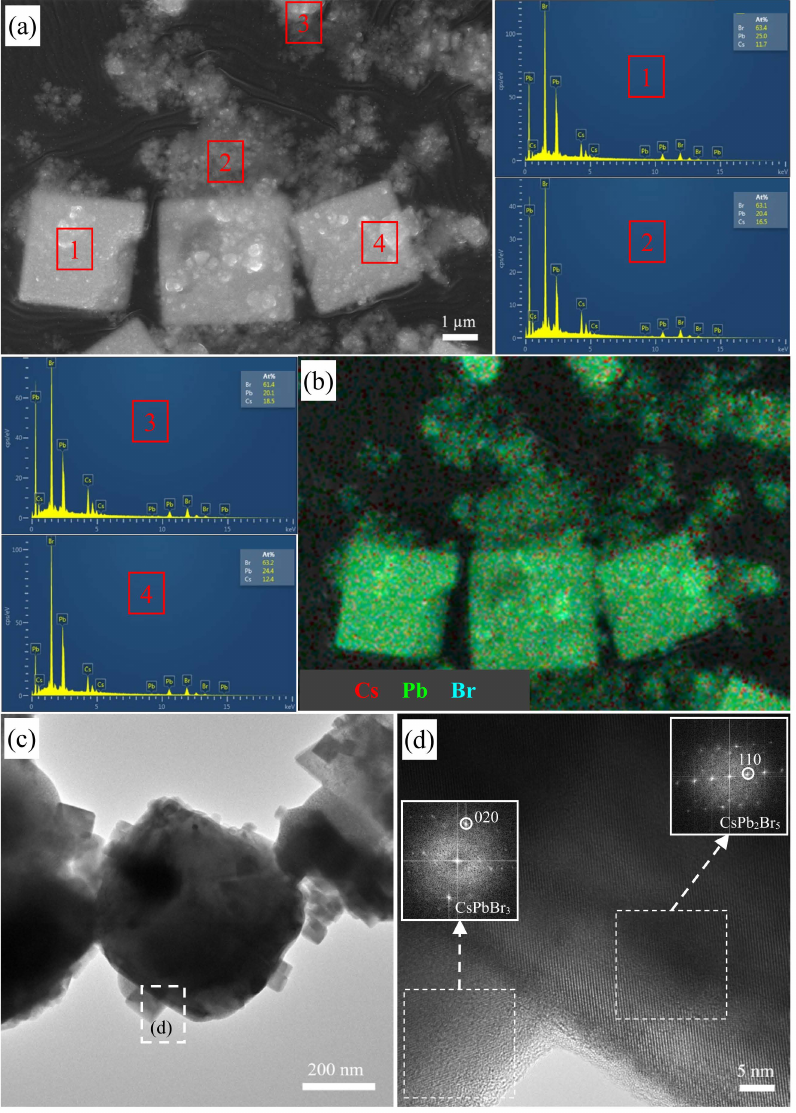
Figure 8. ( a ) SEM image of the CsPbBr 3 precursor and its corresponding EDS spectra of the points 1, 2, 3, and 4. ( b ) The elemental overlay of Cs, Pb, and Br for the CsPbBr 3 precursor. ( c ) TEM and ( d ) HRTEM images of the CsPbBr 3 precursor; insets: FFT